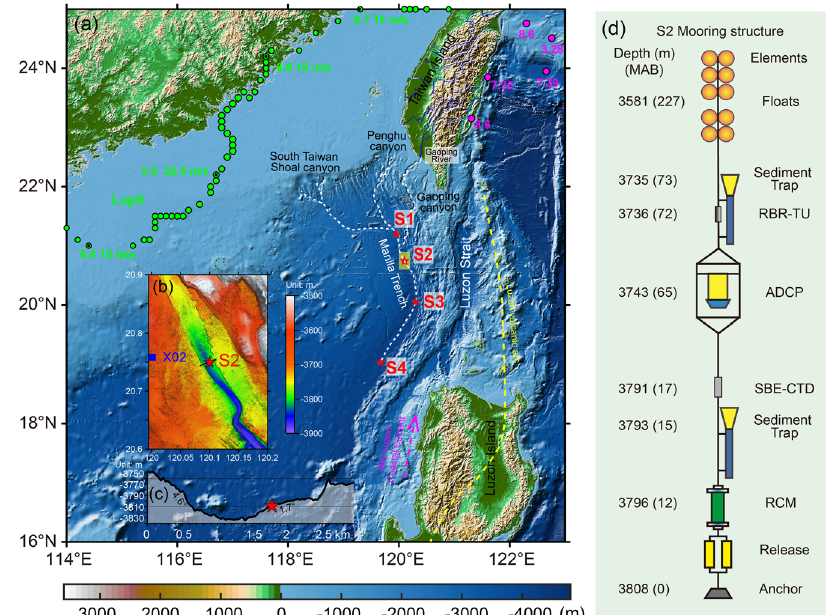
Fig. 1 Mooring locations in the Manila Trench. a Bathymetric map of the northeast South China Sea showing the mooring locations. The white dashed lines indicate the Manila Trench and three submarine canyons upstream. The red stars denote the mooring locations (S1 – S4). The area inside the yellow rectangle is zoomed in ( b ). The green dots are the tracks of Tropical Storm Lupit happened in August 2021, and the corresponding wind speeds are shown. The magenta dots show the earthquake source centers before occurrence of the turbidity currents. b Multi-beam bathymetric measurements showing the sea fl oor topography covering the mooring site S2 (indicated by the red star). The blue square indicates the box sampling site X02. And the black line indicates the location of cross section of ( c ). c Cross-trench section of the thalweg channel at the mooring sites S2 (the red star). d Schematic diagram of the mooring. The depth, height in meters above the seabed (MAB), and the corresponding instruments are indicated. The detailed information of instruments is introduced in materials and methods.